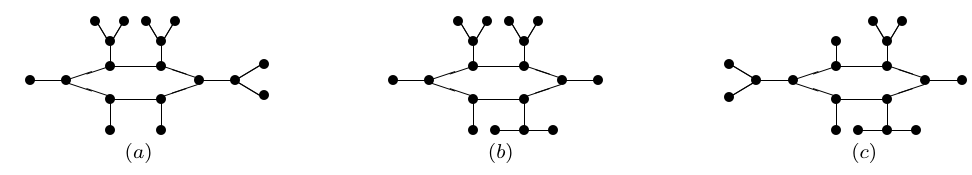
Fig.10. Three possible graphs with the proof of Lemma 3.14 Figure 10. ( a – c ) Three possible graphs with the proof of Lemma